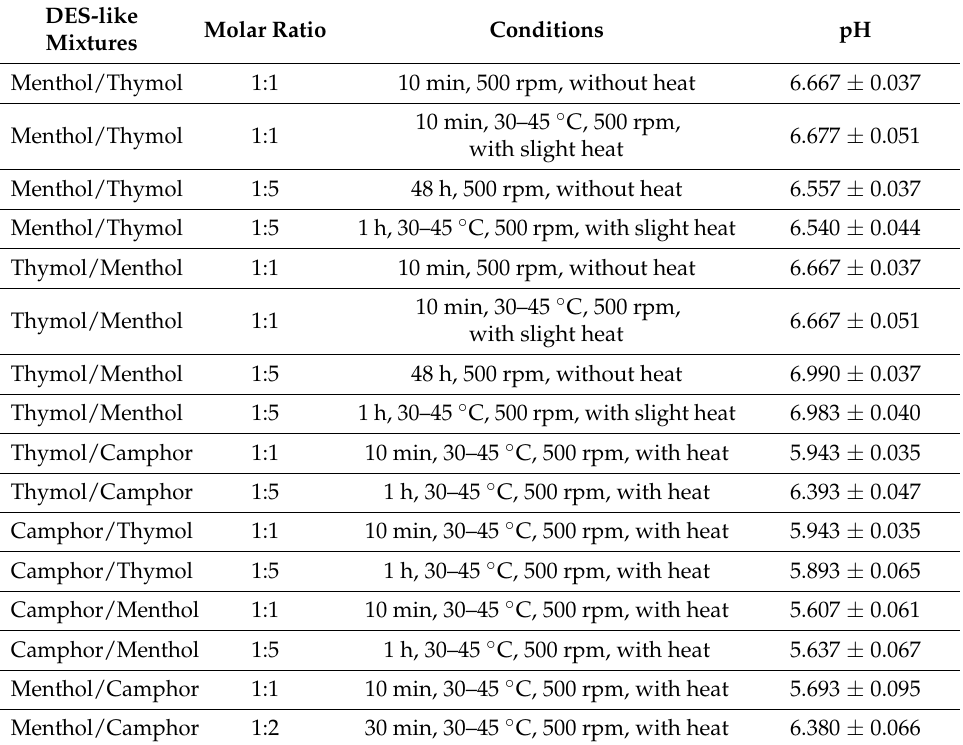
Table 5. The pH of hydrophobic DES-like mixtures with and without heat (adapted according to Sekharan et al.)